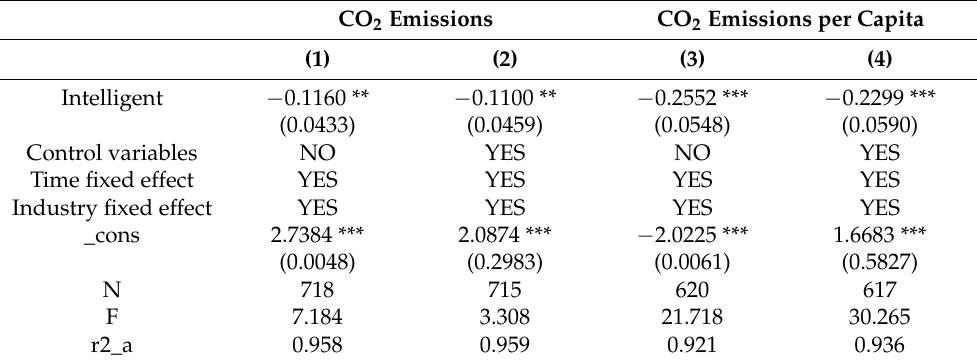
Table 2. The impact of intelligent manufacturing on carbon emissions under different types of emission indicators.